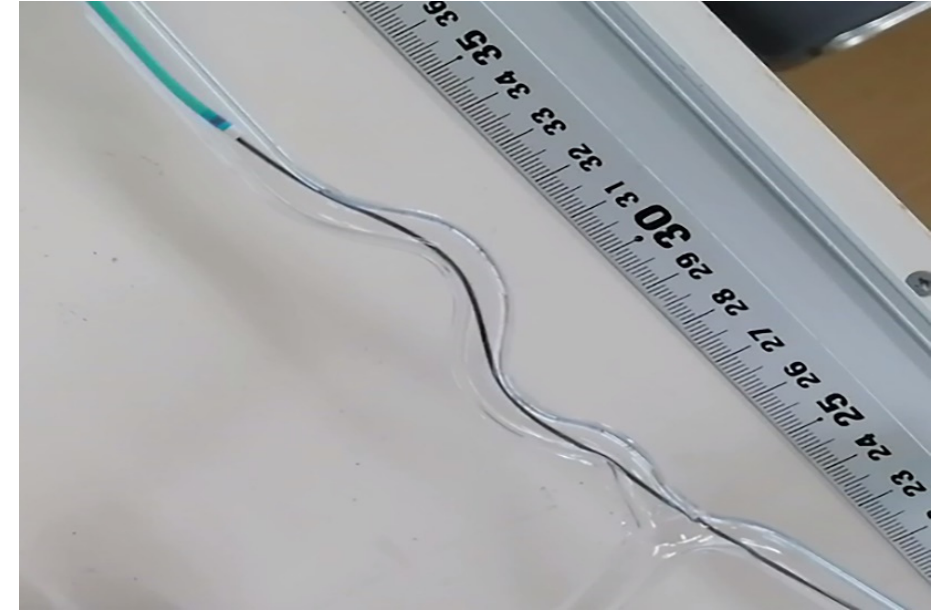
Figure 20. The initial situation under condition 2.